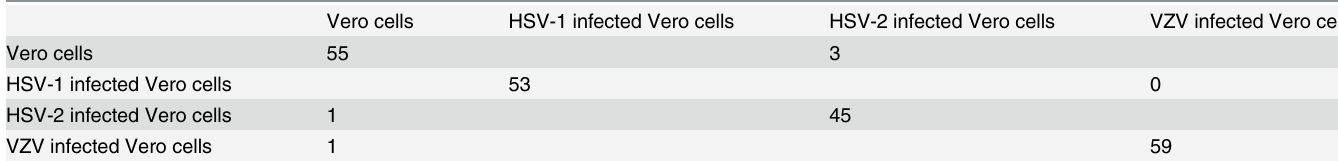
Table 1. Performances of LDA calculations for the first strategy. The calculations were performed in order to differentiate between all four classes — con- trol Vero cells, HSV-1 infected Vero cells, HSV-2 infected Vero cells and VZV infected Vero cells using 13 PCs.